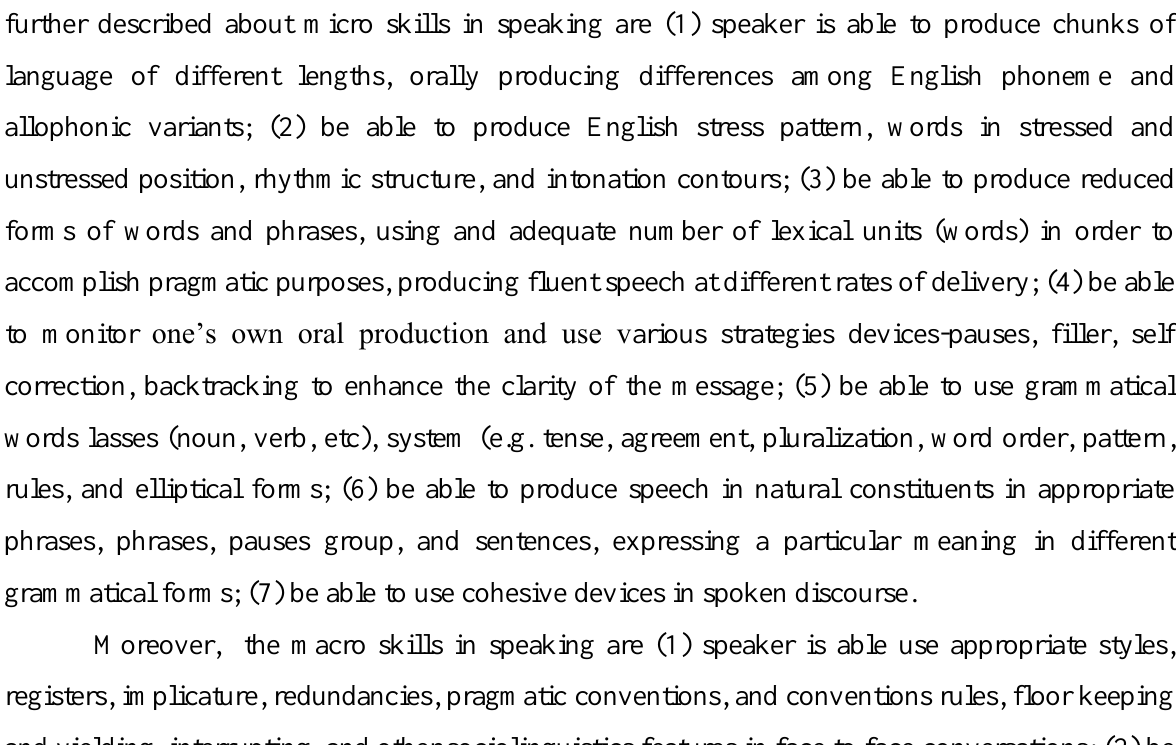
phrases, phrases, pauses group, and sentences, expressing a particular meaning in different grammatical forms; (7) be able to use cohesive devices in spoken